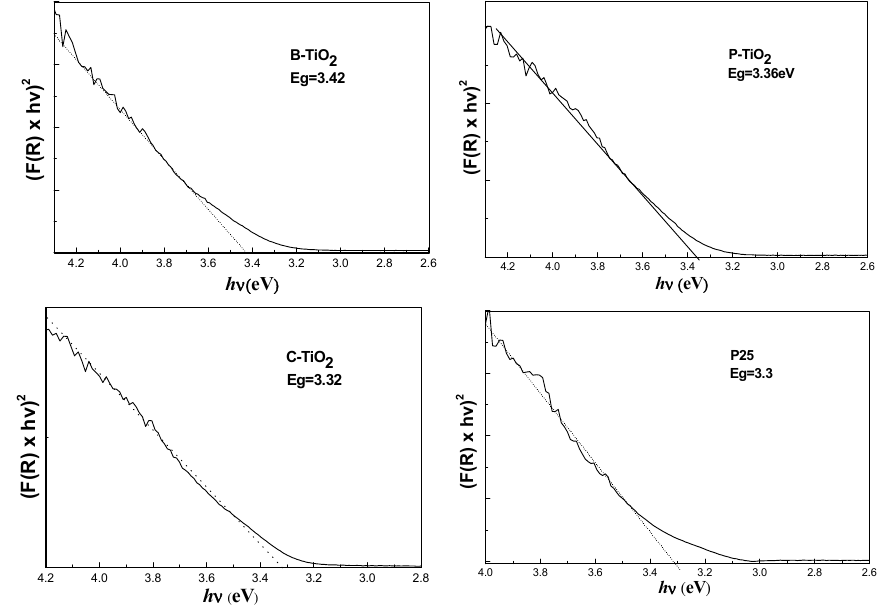
Figure 12. The normalized plots derived from the calculated data using Equation (1) based on the absorption data of Figure 11.